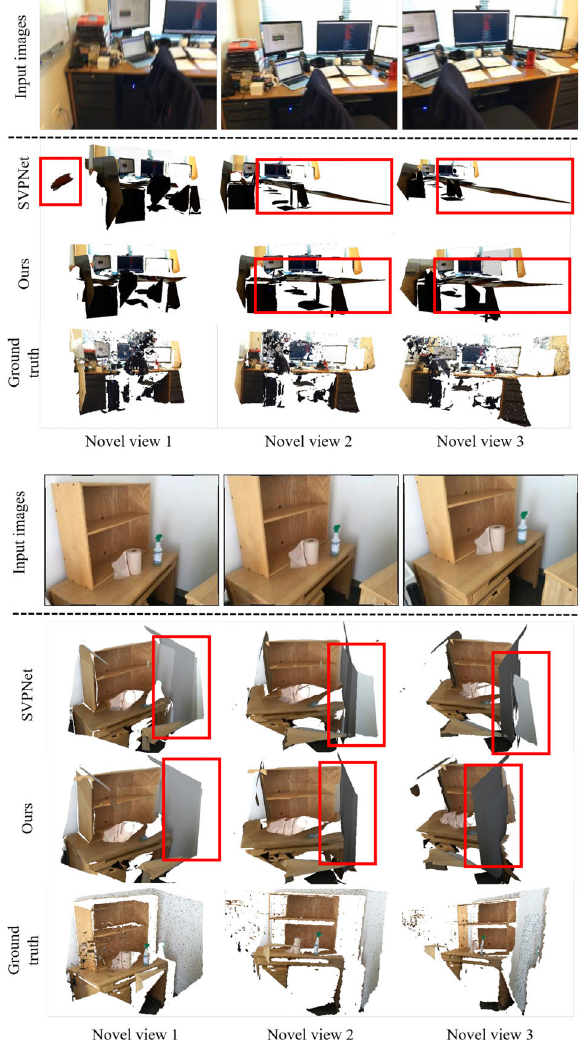
Fig. 6 The reconstruction results of two scenes from multiple images using our method and SVPNet